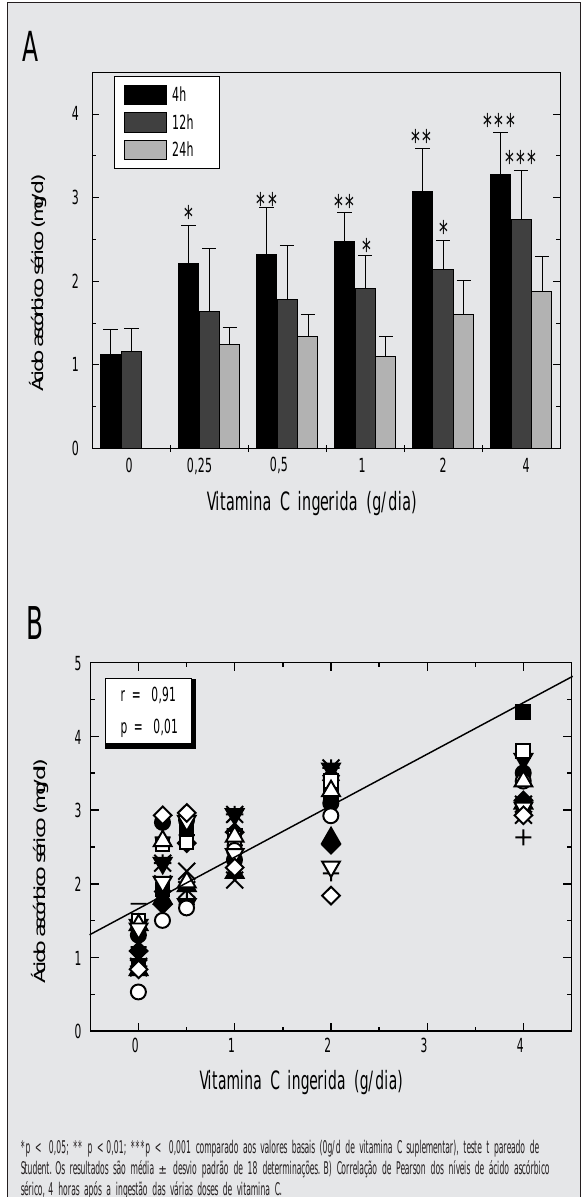
Figura 1 – Níveis séricos de ácido ascórbico após a ingestão de vitamina C. A) Concentração sérica do ácido ascórbico determinada pelo método espectrofotométrico da 2,4-dinitrofenil-hidrazina